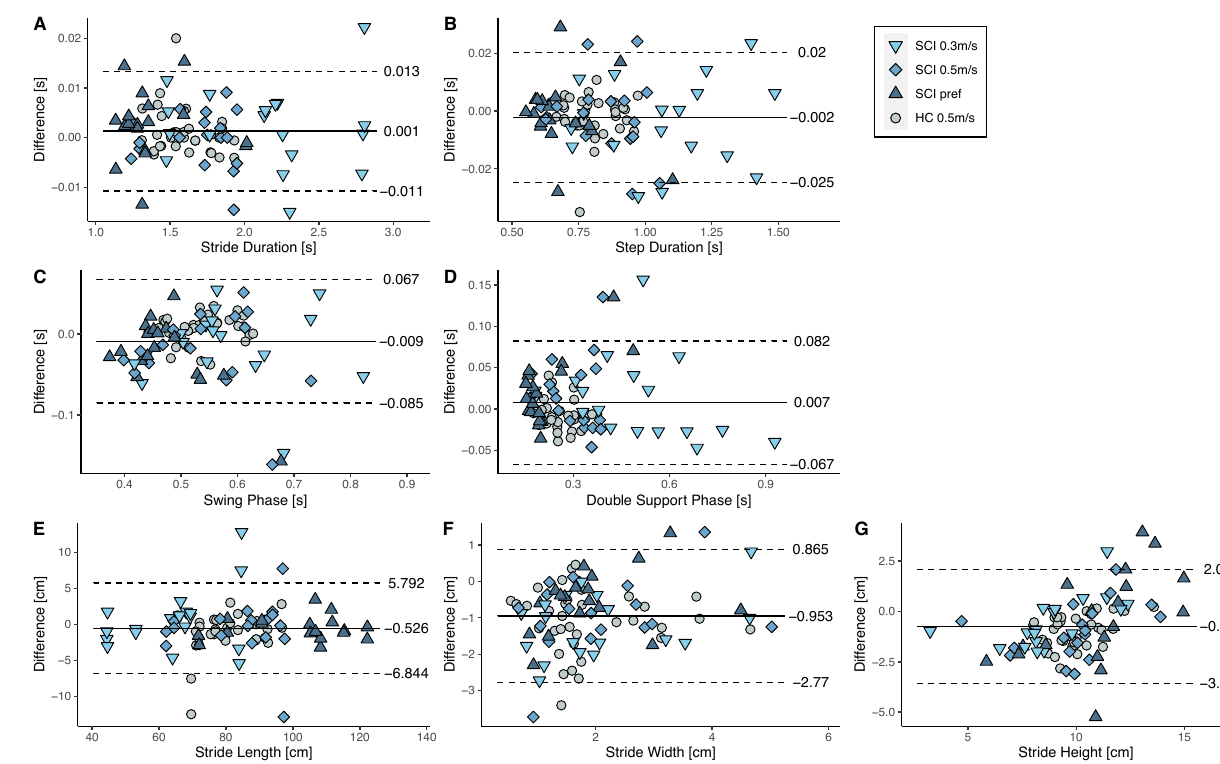
Figure 6. Bland-Altmann analysis of the differences between the sensor-derived gait parameters and the ground truth gait parameters for HC walking at 0.5m/s and SCI walking at 0.3m/s, 0.5m/s, and at their preferred speed. Differences are shown for the stride duration ( A ), step duration ( B ), swing phase ( C ), double support phase ( D ), stride length ( E ), stride width ( F ), and stride height ( G ). The black line indicates the mean difference between the two setups and the dashed lines represent the upper and lower limits of